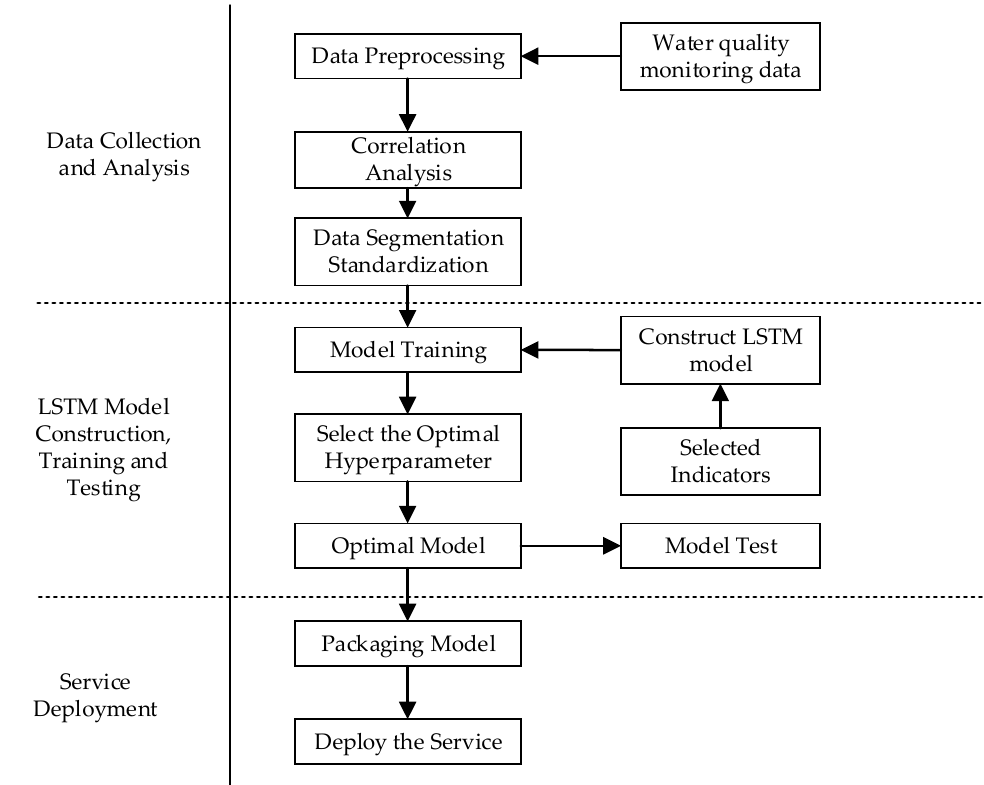
Figure 3. Model construction process of water quality prediction based on LSTM.